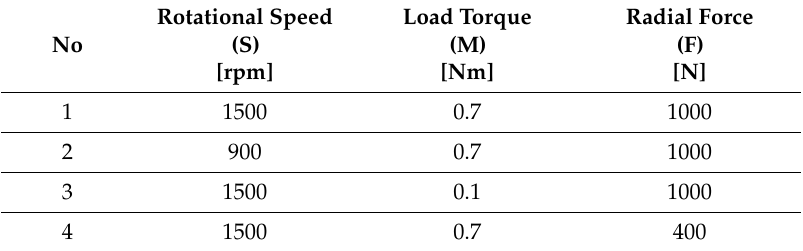
Table 1. Operating Conditions.